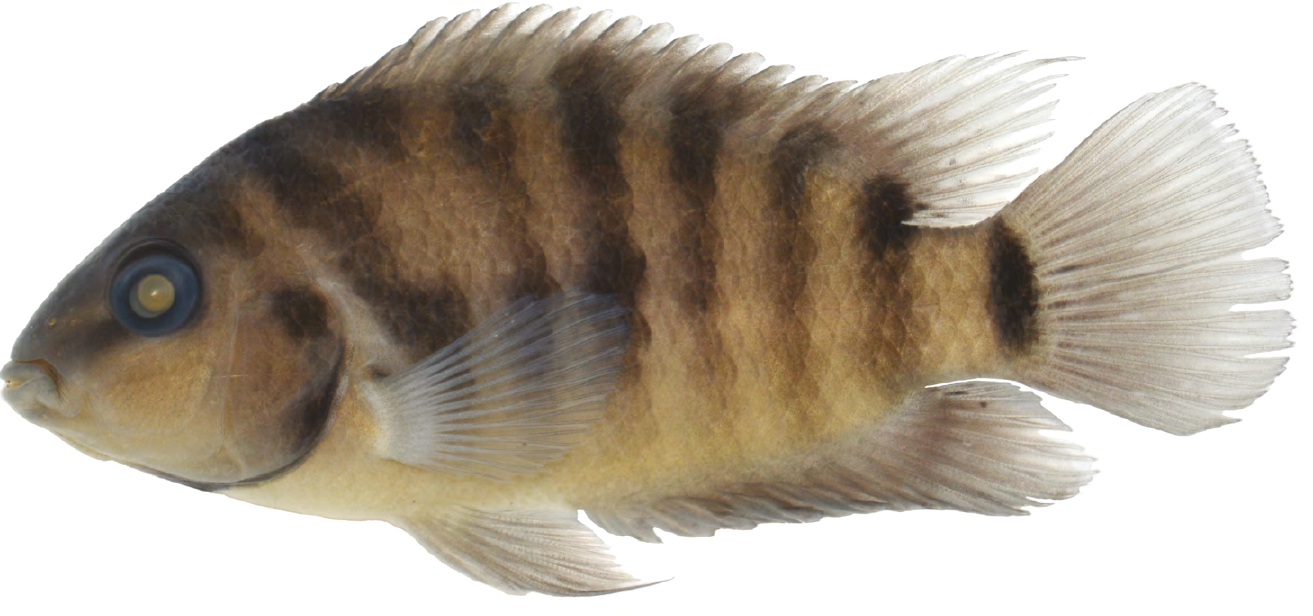
Figure 6: Preserved specimen of A . nigrofasciata (MPUJ 8463) displaying body coloration